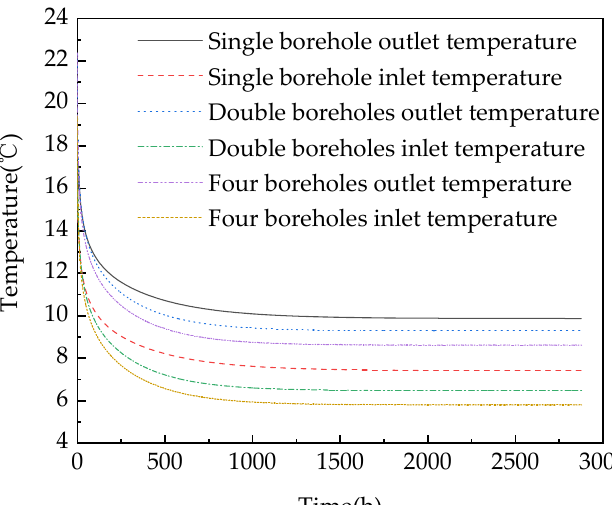
Figure 8. Changes in the inlet and outlet temperatures in summer.